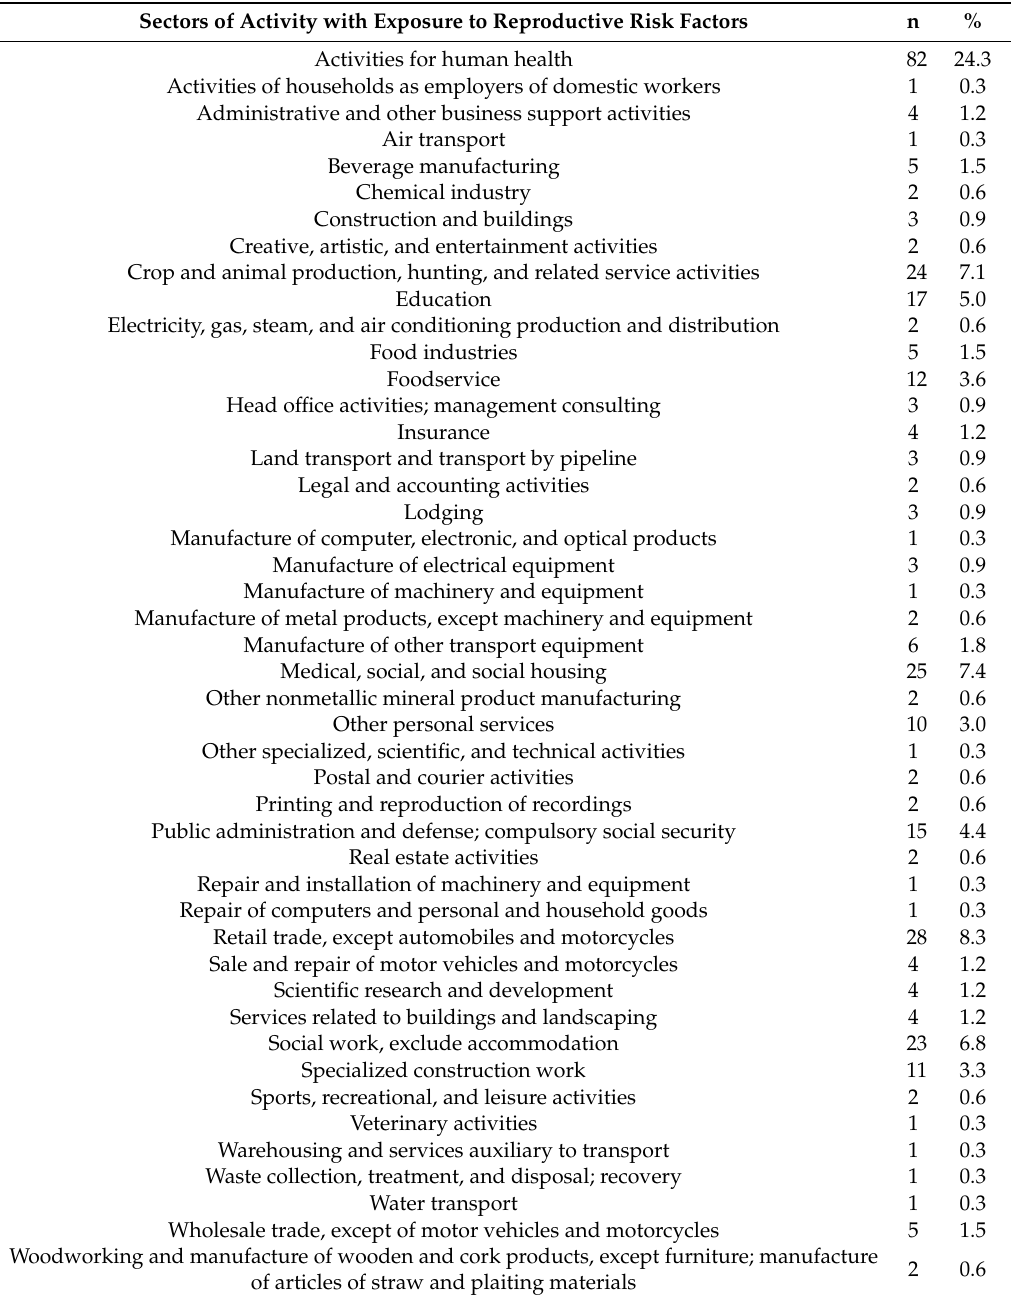
Table 5. Description of sectors of activity for which exposure to reproductive risk factors was identified for employed patients (n = 579) seen in interviews at the ARTEMIS Center from 16 February 2016 to 1 June